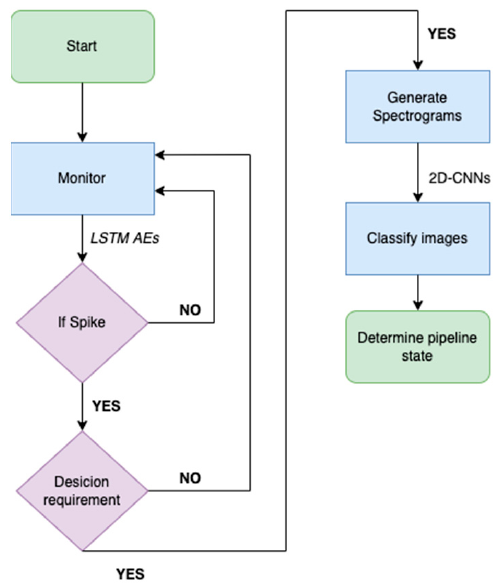
Figure 9. Proposed methodology flowchart.